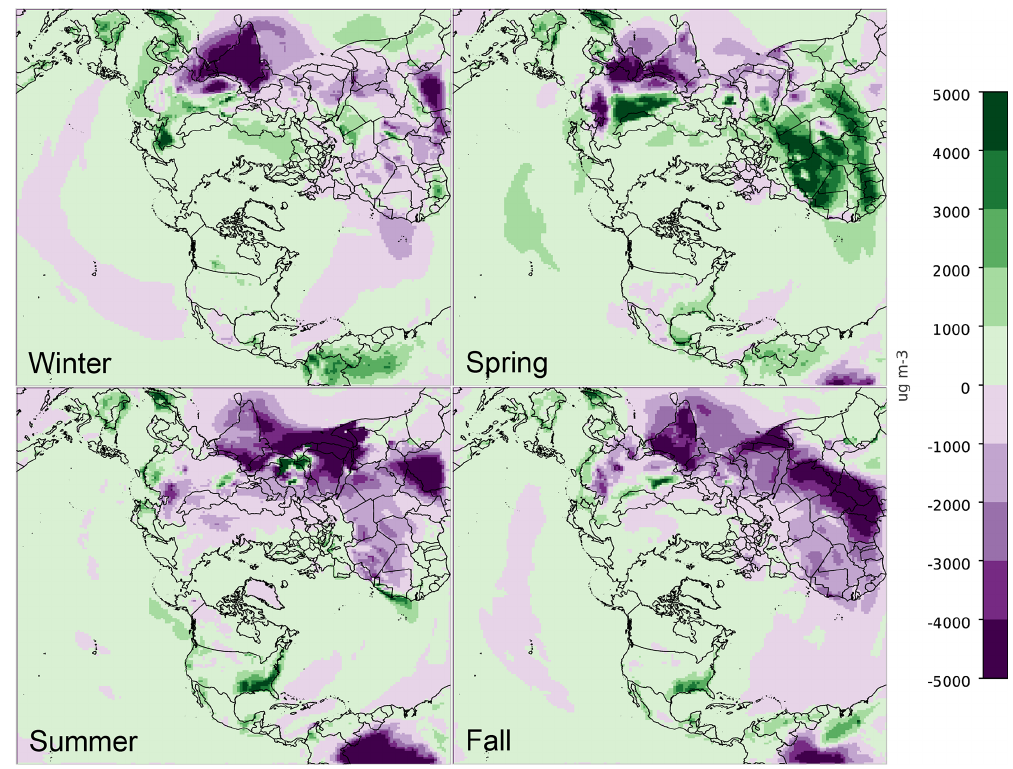
Figure 11. Difference in seasonal average surface PM 2 . 5 concentrations (µgm − 3 ; all hours) between the HCMAQ521 and HC- MAQ531_M3Dry simulations (HCMAQ531_M3Dry – HCMAQ521). Green shading indicates higher PM 2 . 5 concentrations and purple shading indicates lower PM 2 . 5 concentrations with the HCMAQ531_M3Dry